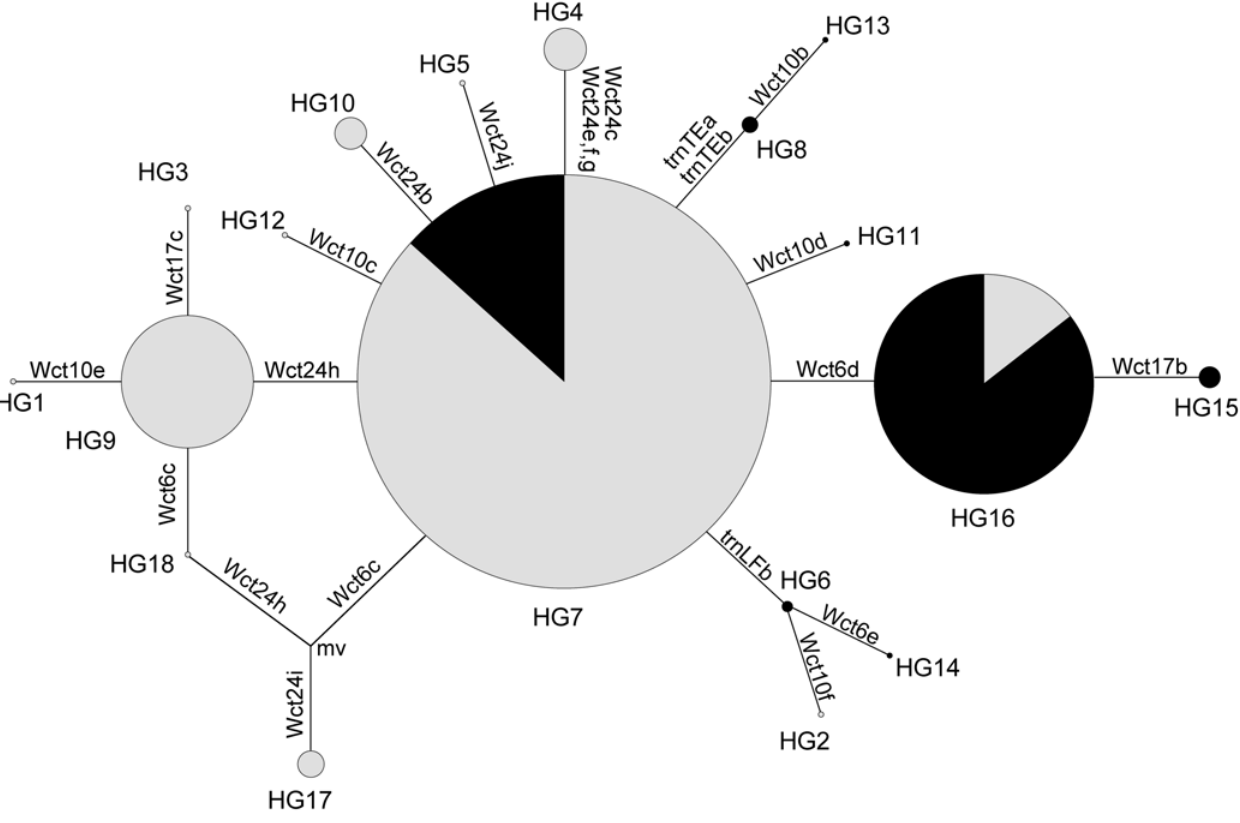
Figure 2. Reduced-median network for chloroplast DNA haplogroups. In total, 21 biallelic sites were used to define the haplogroups (Table S2). Circles denote haplogroups (with diameters proportional to the number of accessions). Mutations that define haplogroups are shown on the branches. mv denotes a hypothetical haplogroup not found in this study. Grey scale indicates geographic origin proportions: grey for western habitats (longitude , 60 u E) and black for eastern habitats (longitude $ 60 u E).